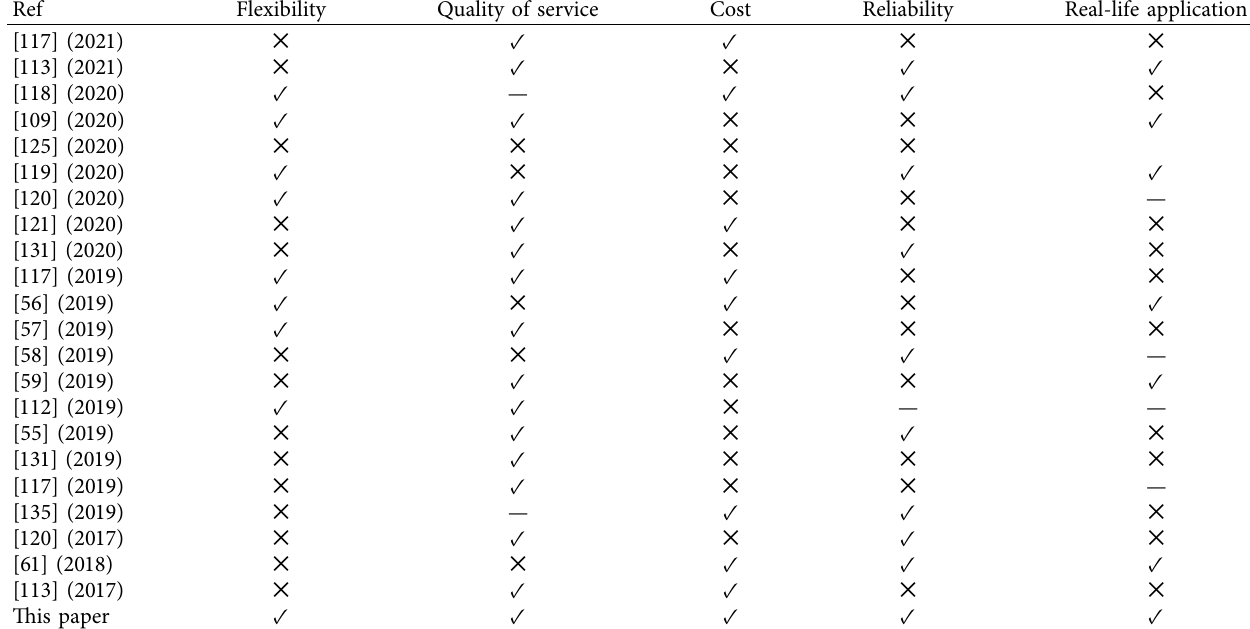
Table 13: Summary of various solutions based on different